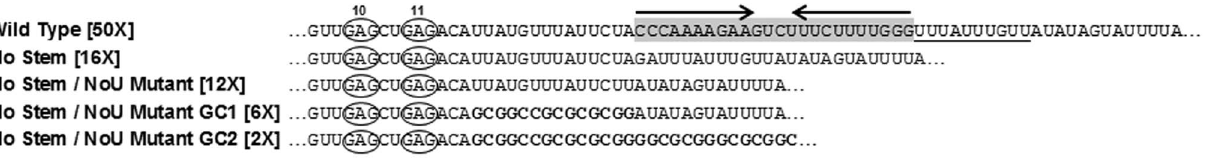
Figure 3. Diagram depicting deletion mutations in the stem-loop and U-stretch of the trp attenuator. The RNA segment that comprises the trp attenuator stem-loop is highlighted by a grey box with arrows indicating the complementary residues that form of the base-paired stem. Residues in the U-stretch of the attenuator are underlined. The sequences in bold show the G + C substitutions made in the regions downstream of the attenuator. The two most downstream of the 11 (G/U)AG triplet repeats (10 and 11) of the TRAP binding site are circled. The TRAP binding site was not altered by any of these deletion mutations. Numbers adjacent to structure names indicate fold TRAP regulation observed in vivo using b - galactosidase assays (results in Table